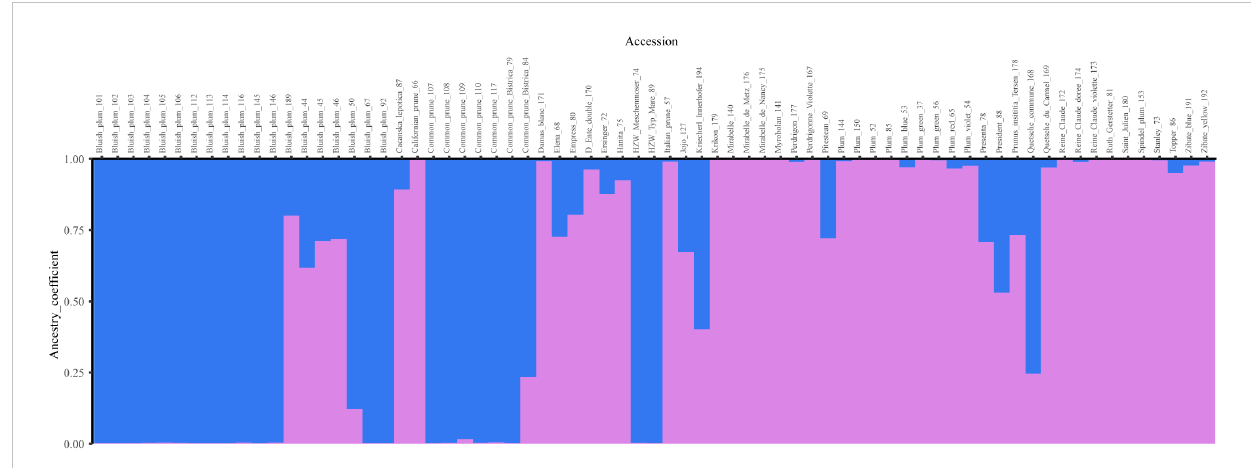
FIGURE 4 Bar plot of Bayesian analysis results (K = 2) for P. domestica accessions. Twenty-two accessions representing mainly local traditional material collected in Slovenia, were assigned to the Cluster 1 (blue). Cluster 2 (violet) consisted of 32 accessions of mixed origin ( in situ and ex situ ) representing different pomological groups. Seventeen accessions were classi fi ed admixed.